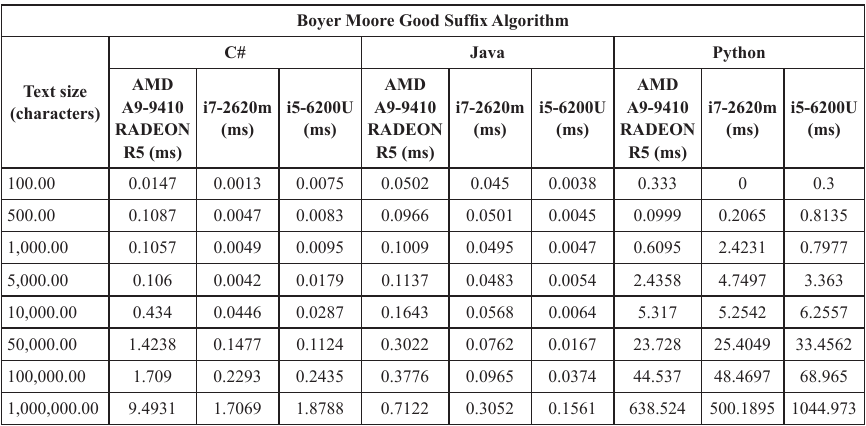
Table 6. Running time of Boyer Moore Good Suffix algorithm in C#, Java and Python programming